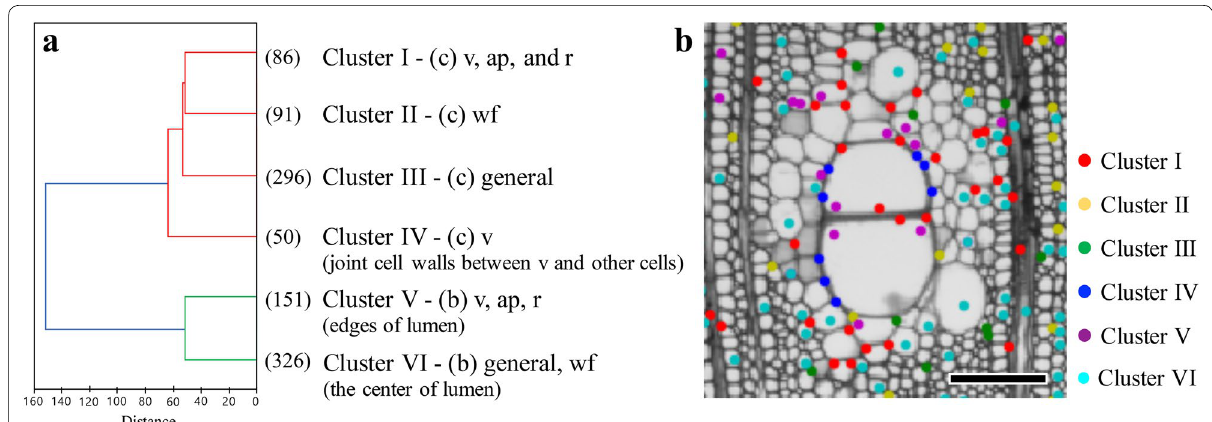
Fig. 4 Dendrogram of 1000 codewords and anatomical elements corresponding to the codewords belonging to each cluster ( a ), and visualization of the clusters on a cross section of Cinnamomum camphora ( b ). The dendrogram was truncated at six clusters, and the numbers in parentheses are the numbers of codewords in the cluster. c corner‑based SIFT feature, b blob‑based SIFT feature, v vessel, ap axial parenchyma cell, r ray, wf